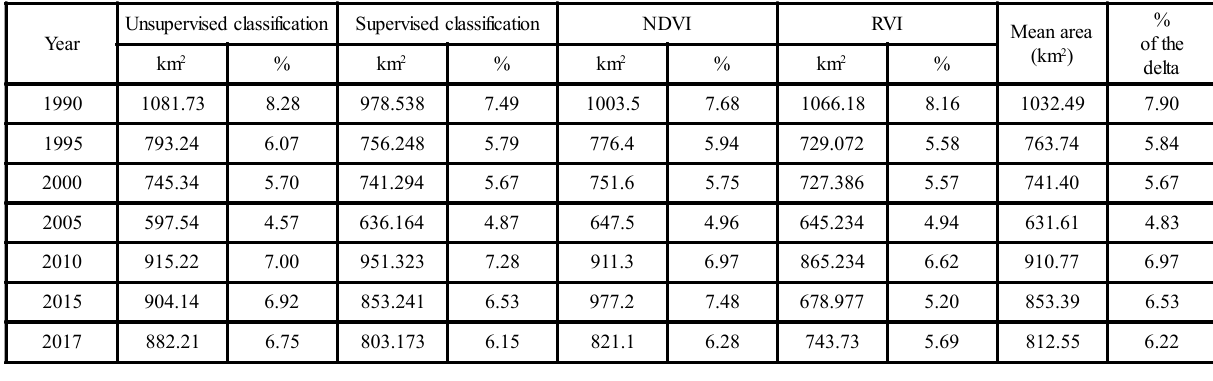
FIG. 3. GRAPHICAL REPRESENTATION OF TEMPORAL DYNAMICS OF VEGETATION IN THE INDUS DELTA TABLE 4. STATISTICAL SUMMARY OF THE TEMPORAL DYNAMICS OF MANGROVES IN THE INDUS DELTA